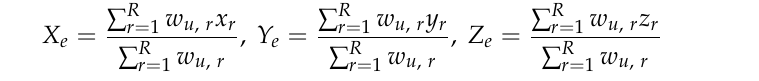
Table 1. Detailed structure of DNN model.